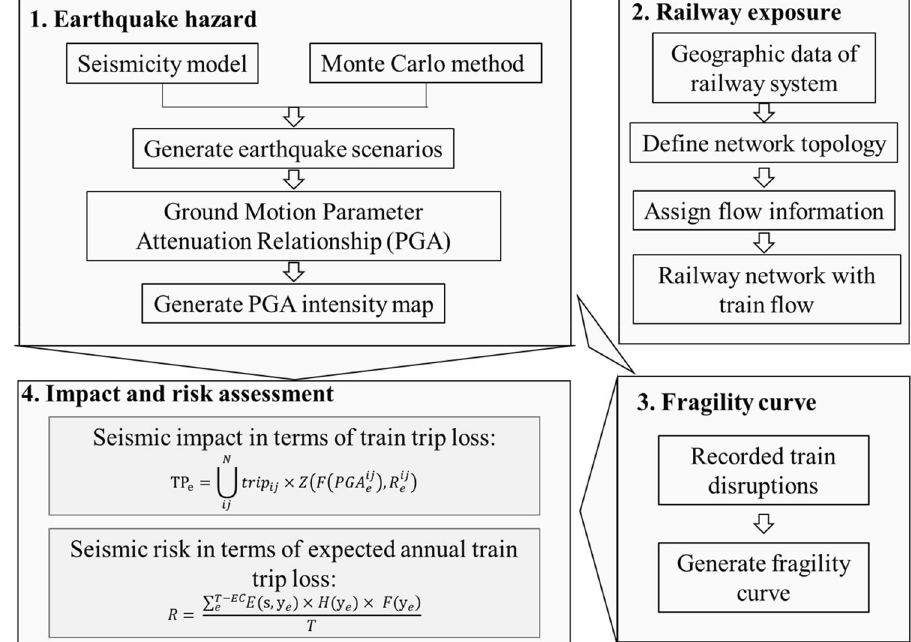
assessing seismic impact and risk to railway